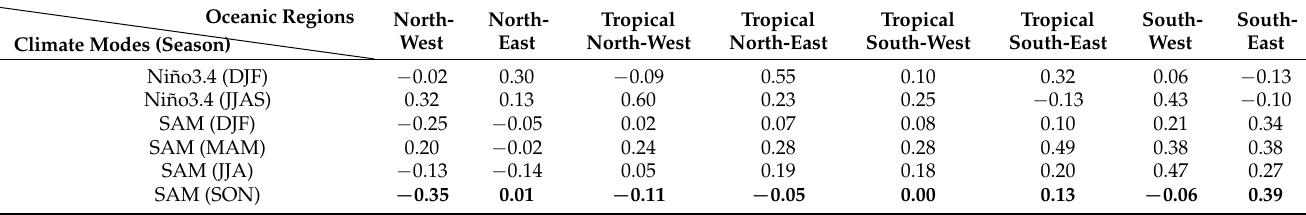
Table 2. Correlations between seasonally averaged interannual anomalies of extreme wave occurrence averaged in different open-ocean regions and climate modes. Correlations significant at the 95% level according to a Student t -test are displayed in